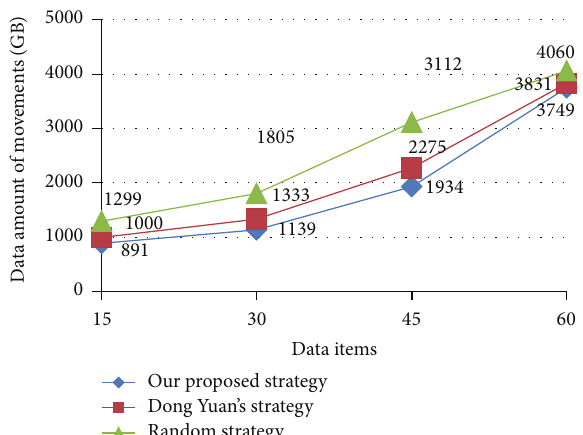
Figure 6: Total data movement amount with 10% fixed-position datasets.